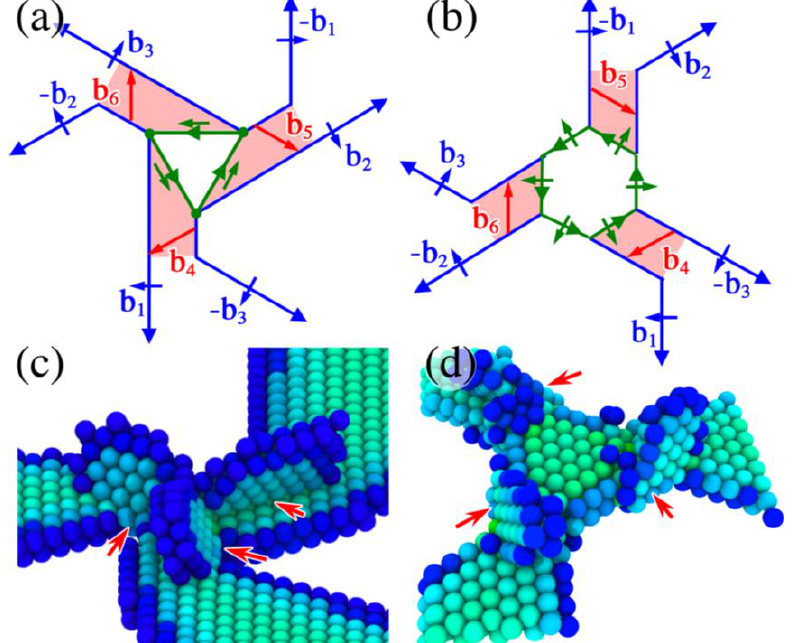
Figure 5. Mechanisms for lattice dislocation nucleation from the volume condensed nodes with triangular ( a , c ) and hexagonal ( b , d ) dislocation patterns. In ( a , b ), the nucleation sites for the lattice dislocations are marked by the red shaded areas; ( c , d ) show the dislocation configuration at nodes after the nucleation of